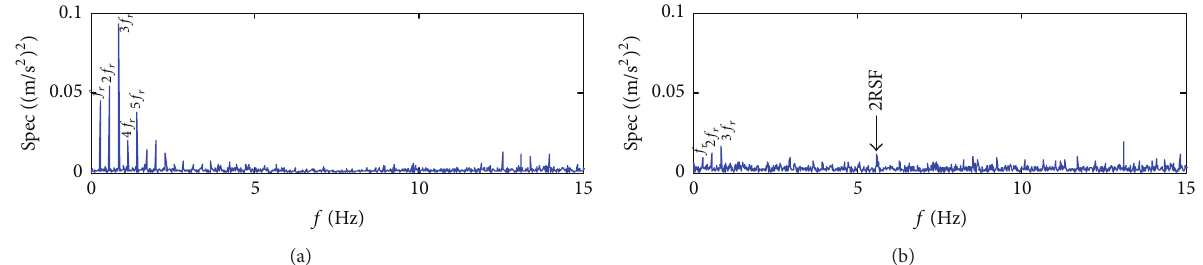
Figure 11: Envelope spectrum after band-pass filtering. (a) Normal and (b) fault.